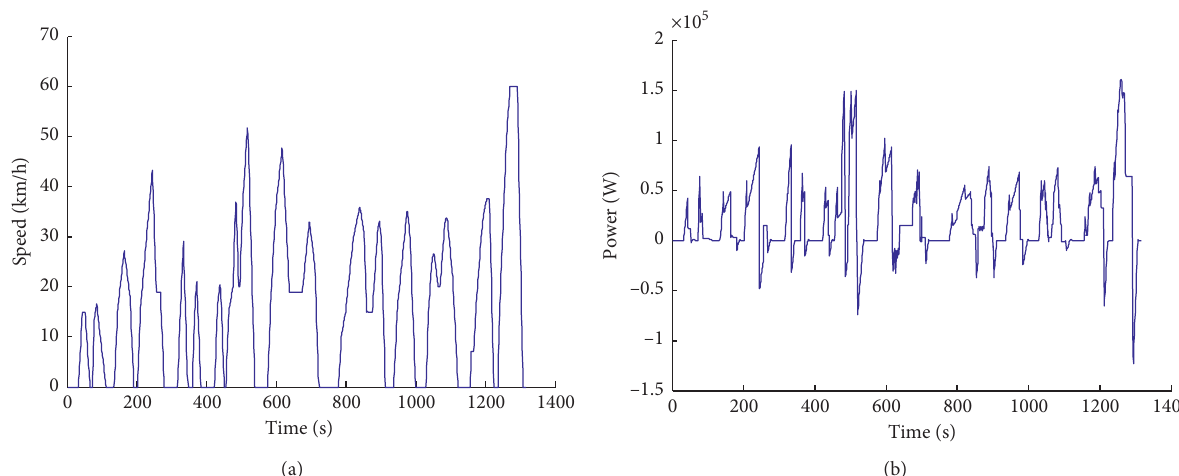
Figure 8: (a) The speed of CYC-CHINA. (b) The required power of CYC-CHINA.